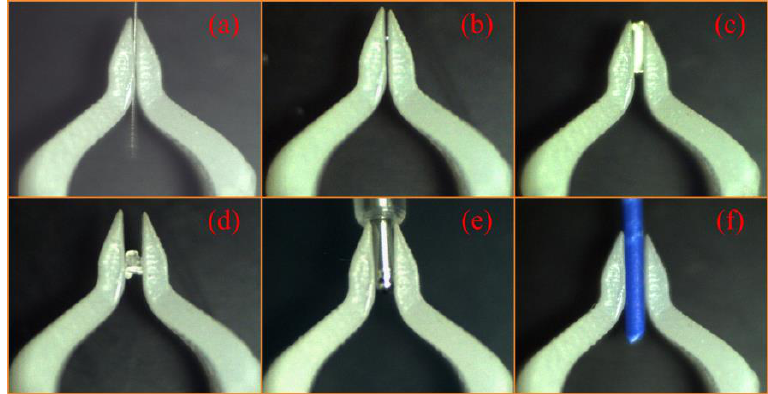
Figure 15. Cases of micromanipulation tasks: ( a ) holding a single mode fiber of 125 μm; ( b ) manipulation of a 200 μm diameter solder ball; ( c ) manipulation of a 440 μm resistance; ( d ) clamping an irregular crystal of 550 μm; ( e ) manipulation of a 700 μm microcomponent; and ( f ) manipulating a wire cable of 860 μm.